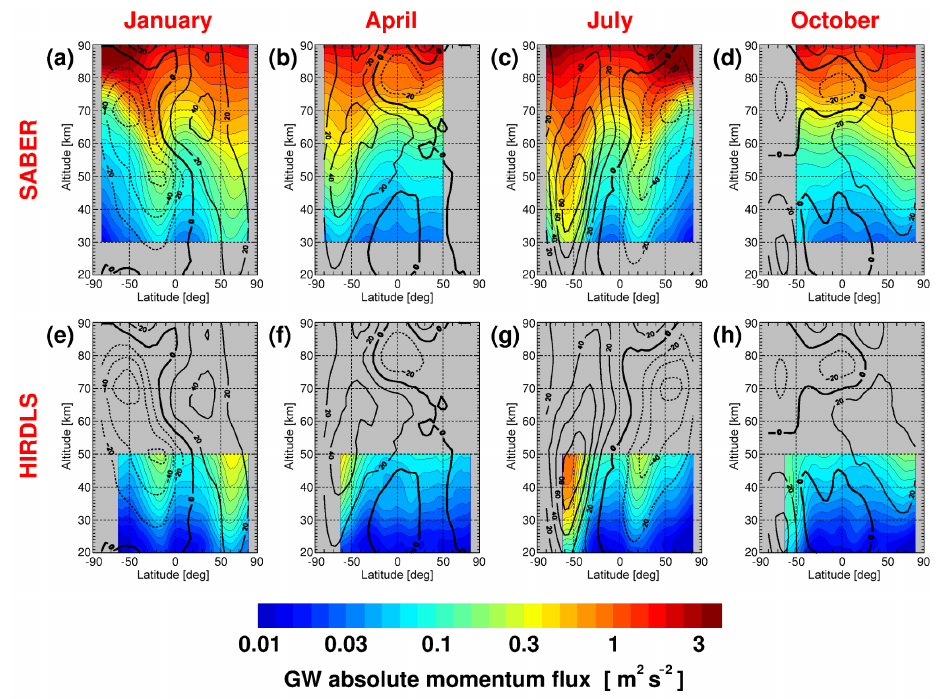
Figure 12. Same as Fig. 11 but for gravity wave absolute momentum flux in m 2 s − 2 .